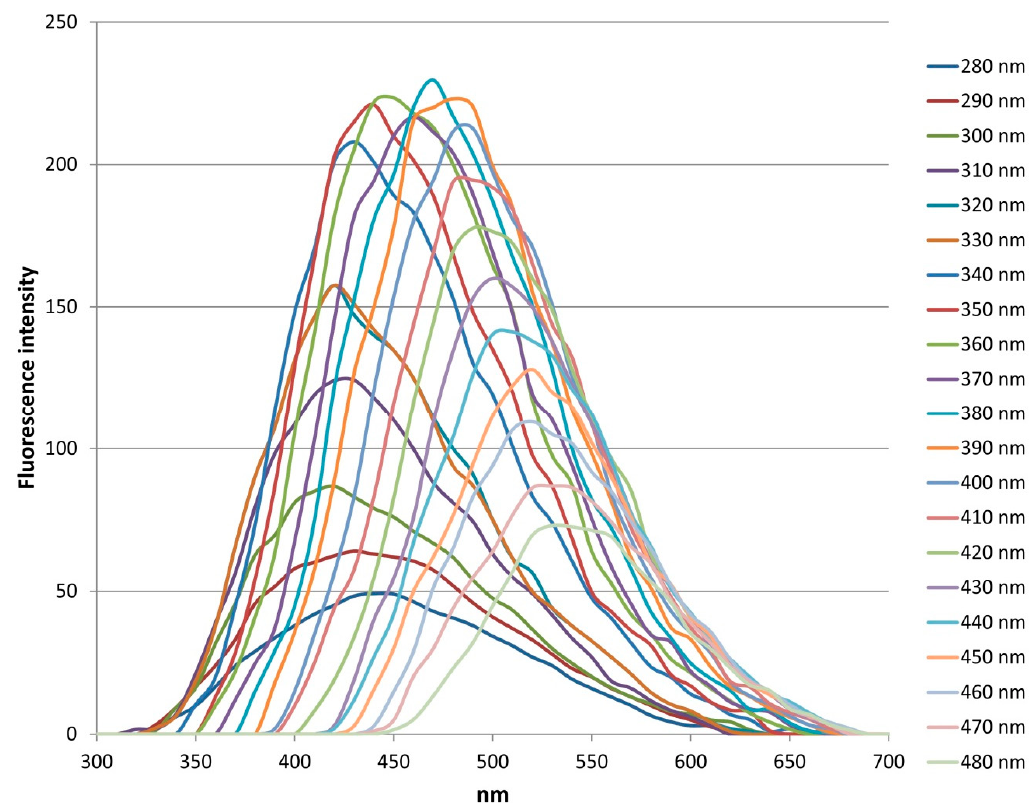
Figure 4. Fluorescence emission spectra of the synthesized CNDs-DS for excitation wavelengths between 280 and 480 nm.